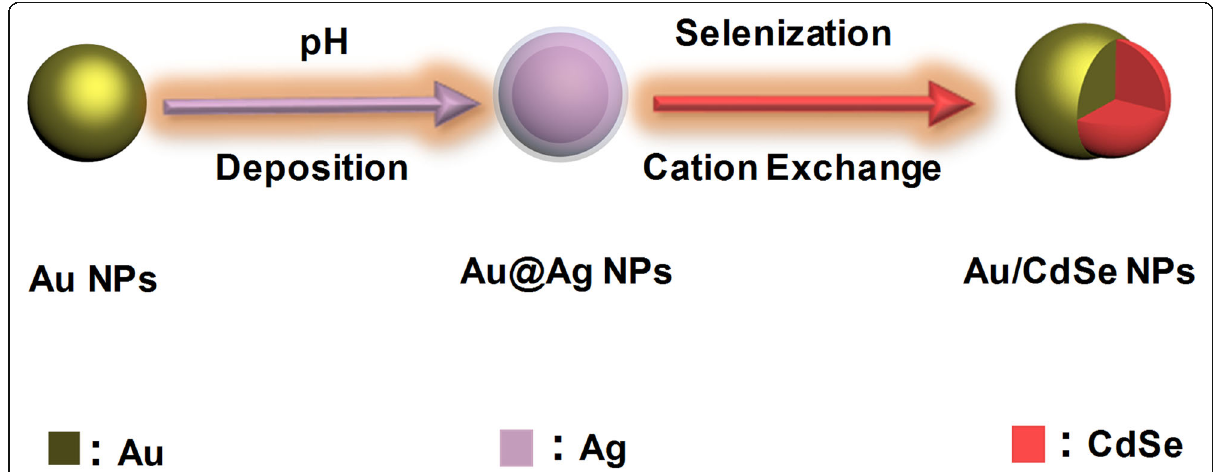
Fig. 1 Schematic illustration for the synthesis of Au/CdSe Janus